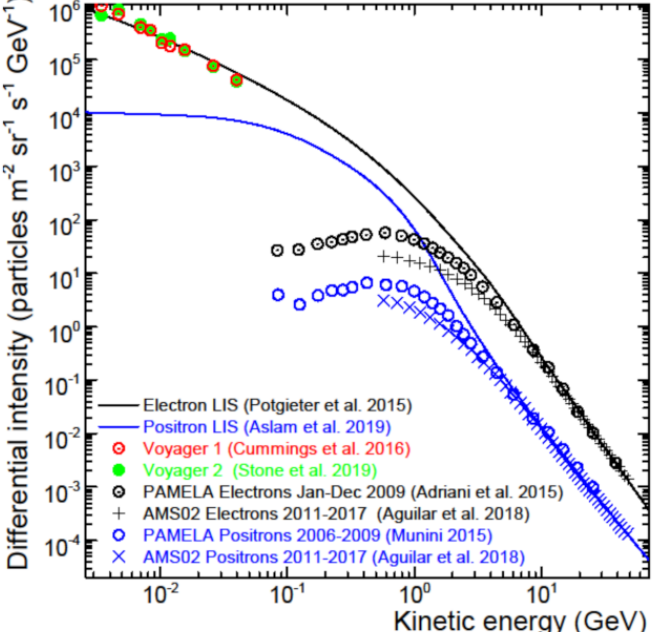
Figure 7. The computed VLIS for electrons (black line) from [43] and positrons (blue line) from [45] in comparison with observations from Voyager 1 [6,19] and Voyager 2 [7] at the HP, and observational averages from PAMELA [113] and AMS-02 [5] at the Earth as indicted in different colours. Figure is amended from